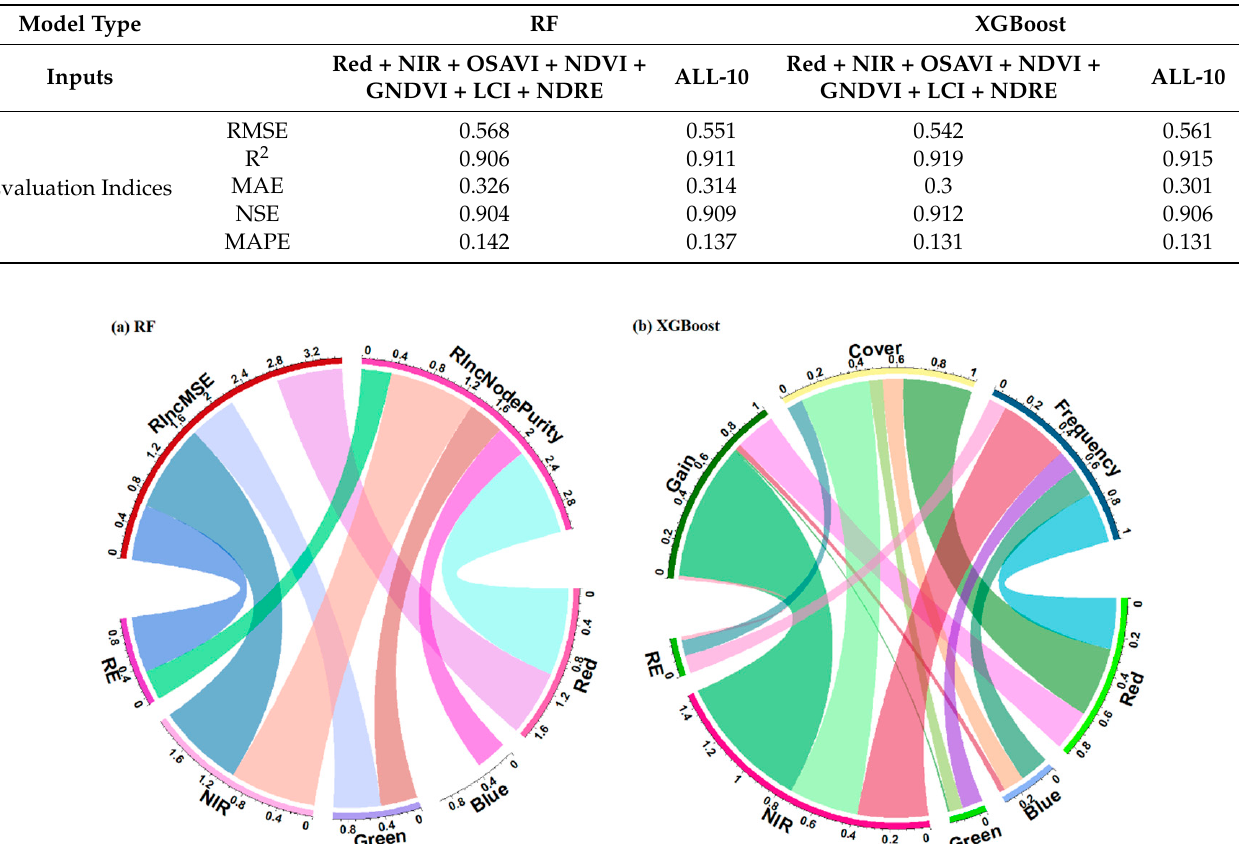
Table 2. Statistical evaluation for RF and XGBoost with multispectral bands (B) as input variables.